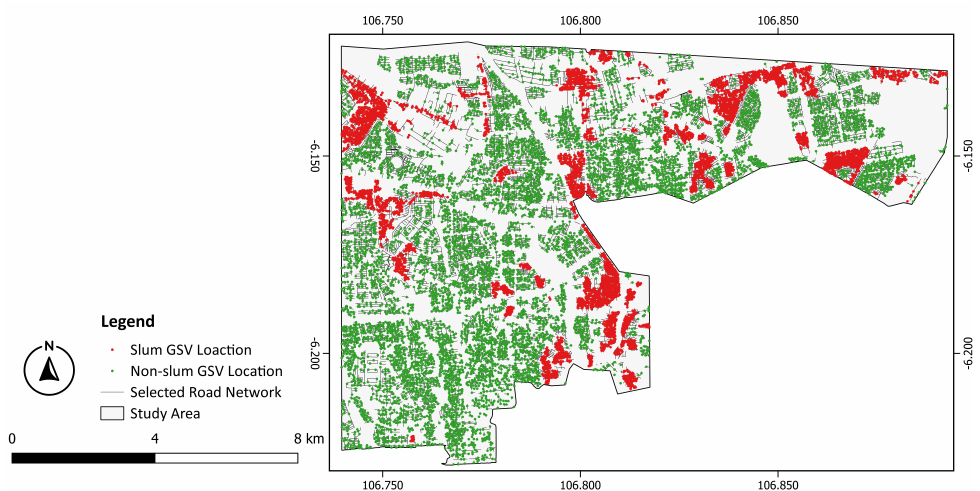
Figure 4. Random point locations on roadways in both slum and non-slum areas (green are non-slum point and red are slum point).